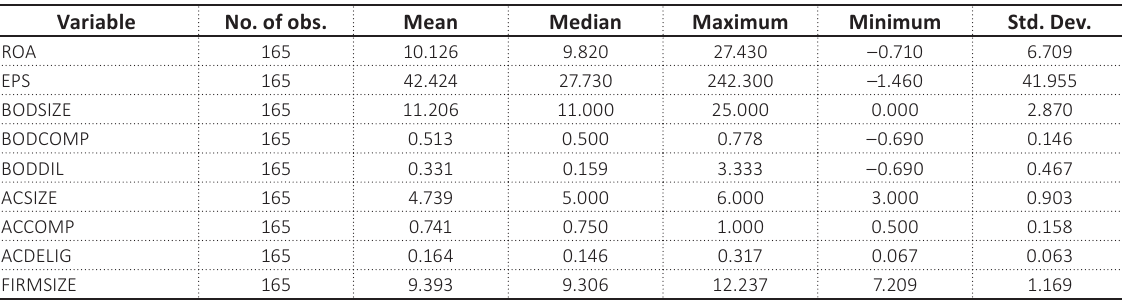
Table 2. Descriptive analysis